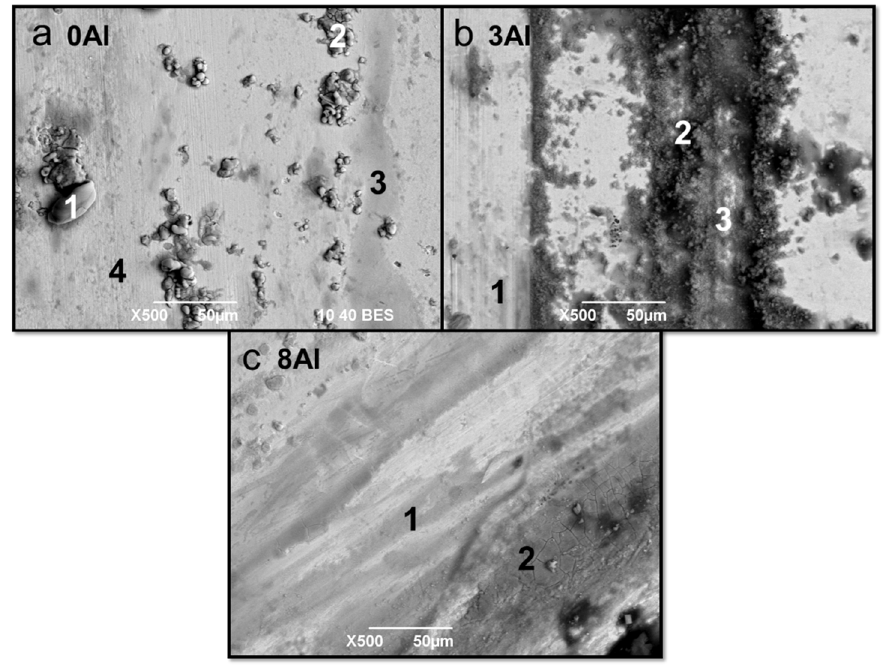
Figure 9. SEM images of the ( a ) 0Al; ( b ) 3Al; ( c ) 8Al alloys under total wear test, T. The numbers correspond to the spectrum showed in Table 7. Table 7. EDS composition (wt.%) corresponding to the surfaces of the alloys shown in Figure 9.